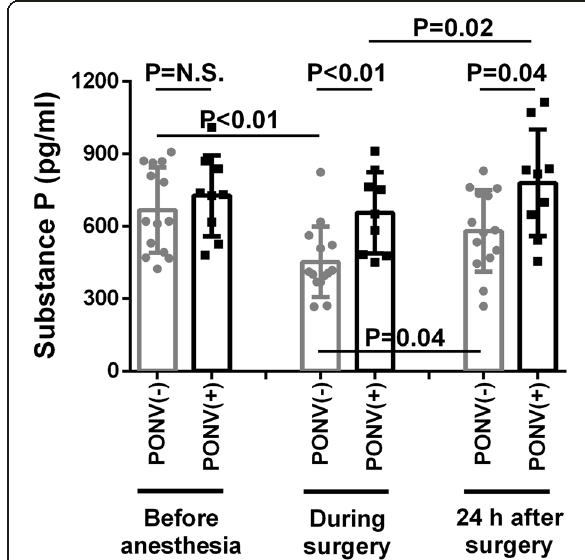
Fig. 1 Plasma substance P concentrations in patients with and without postoperative nausea and vomiting (PONV). Calculated means at baseline before anesthesia, at the end of surgery, and 24 h after surgery were 607, 414, and 579 pg/mL, respectively for PONV(-) and 773, 631, and 879 pg/mL, respectively for PONV